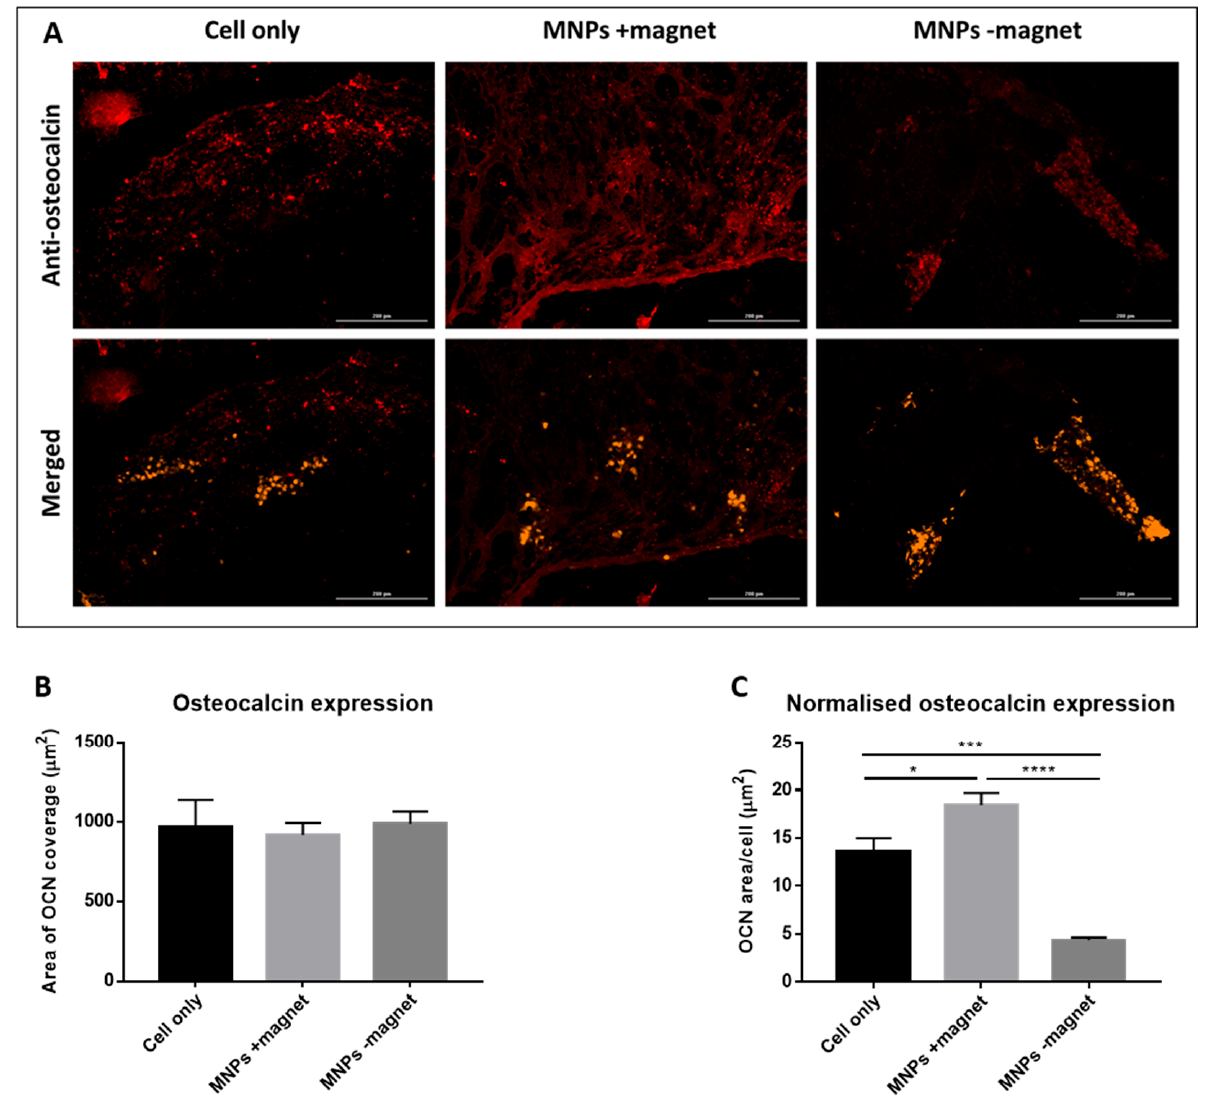
Figure 7. Osteocalcin expression is observed in day 7 extracted hydrogel constructs for all groups (cell only, MNPs +magnet, MNPs − magnet). ( A ) Osteocalcin representative staining at day 7 for all samples. CM-Dil (orange fluorescence) identifies implanted oMSCs, whilst the presence of osteocalcin is depicted by red fluorescence. ( B ) Quantification of osteocalcin expression from images taken from multiple regions of each sample. ( C ) Quantification of osteocalcin expression normalised to cell number, as determined by the number of CM-Dil-positive cells in each image. Significance was determined by a one-way ANOVA statistical test, where * is p < 0.05, *** is p < 0.001 and is **** is p < 0.0001. One sample per group with 3–4 images per sample (n = 3–4). Scale bar = 200 µM.